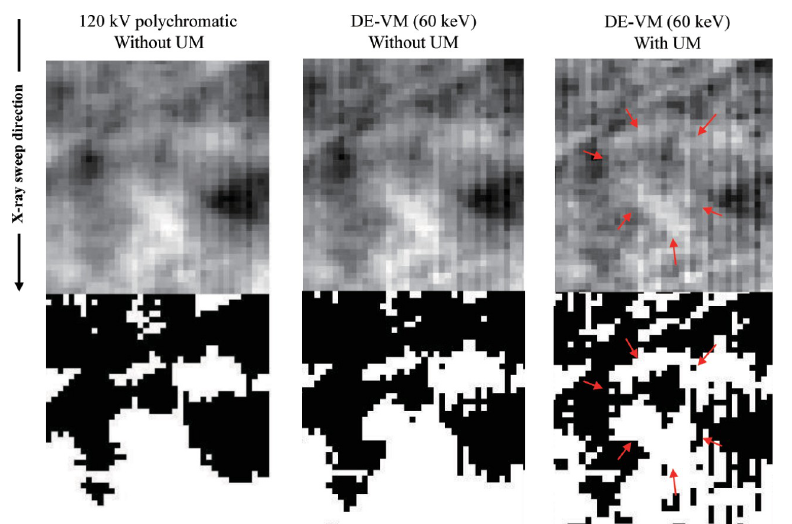
Fig 5. Differences in simulated GGO nodule detection on polychromatic and Virtual Monochromatic (VM) projection-based images. The visibility of the simulated GGO nodule in the projection image is improved by performing UM. The upper row shows the projection image (with/without UM), whereas the lower row shows the global image threshold using Otsu’s method.